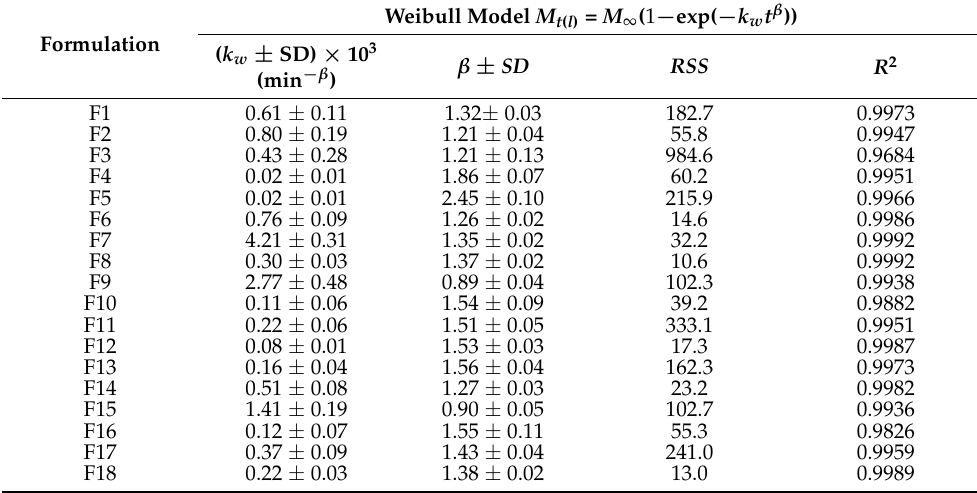
Figure 7. The effect of CRG/CHTS ratio (1:1; 2:1; 3:1), type of dry binder (Prosolv ® SMCC 90, CaSO 4 ), and model drug solubility (TH, SA) on the dissolution behavior of studied matrix tablets. Table 2. Non-linear regression analysis of the dissolution profiles—estimated parameters obtained from fitting the dissolution profiles to the Weibull